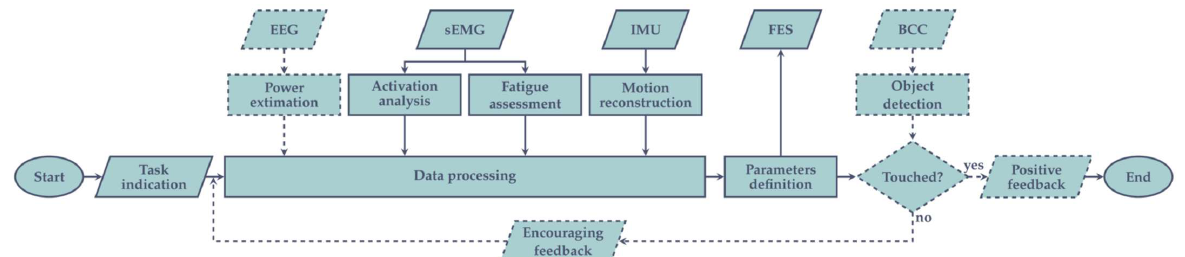
Figure 3. Activity flow of an execution session. After the indication of the task to perform, the subject is required to execute the action. The four sensors are continuously monitored, and for each of them a proper feature is extracted and recorded (e.g., signal power from EEG, limb trajectory from the IMUs). The information obtained by EEG, EMG and IMUs is combined and processed to evaluate how the subject body is reacting, and to decide if the FES must be applied to assist the execution. Therefore, FES parameters are tuned depending on the decision of the processing stage, stabilizing the movement by stimulating one or more muscles, if necessary. Lastly, if the task consists of reaching for an object, the subject is encouraged until the BCC sensors detect the touch of the target.